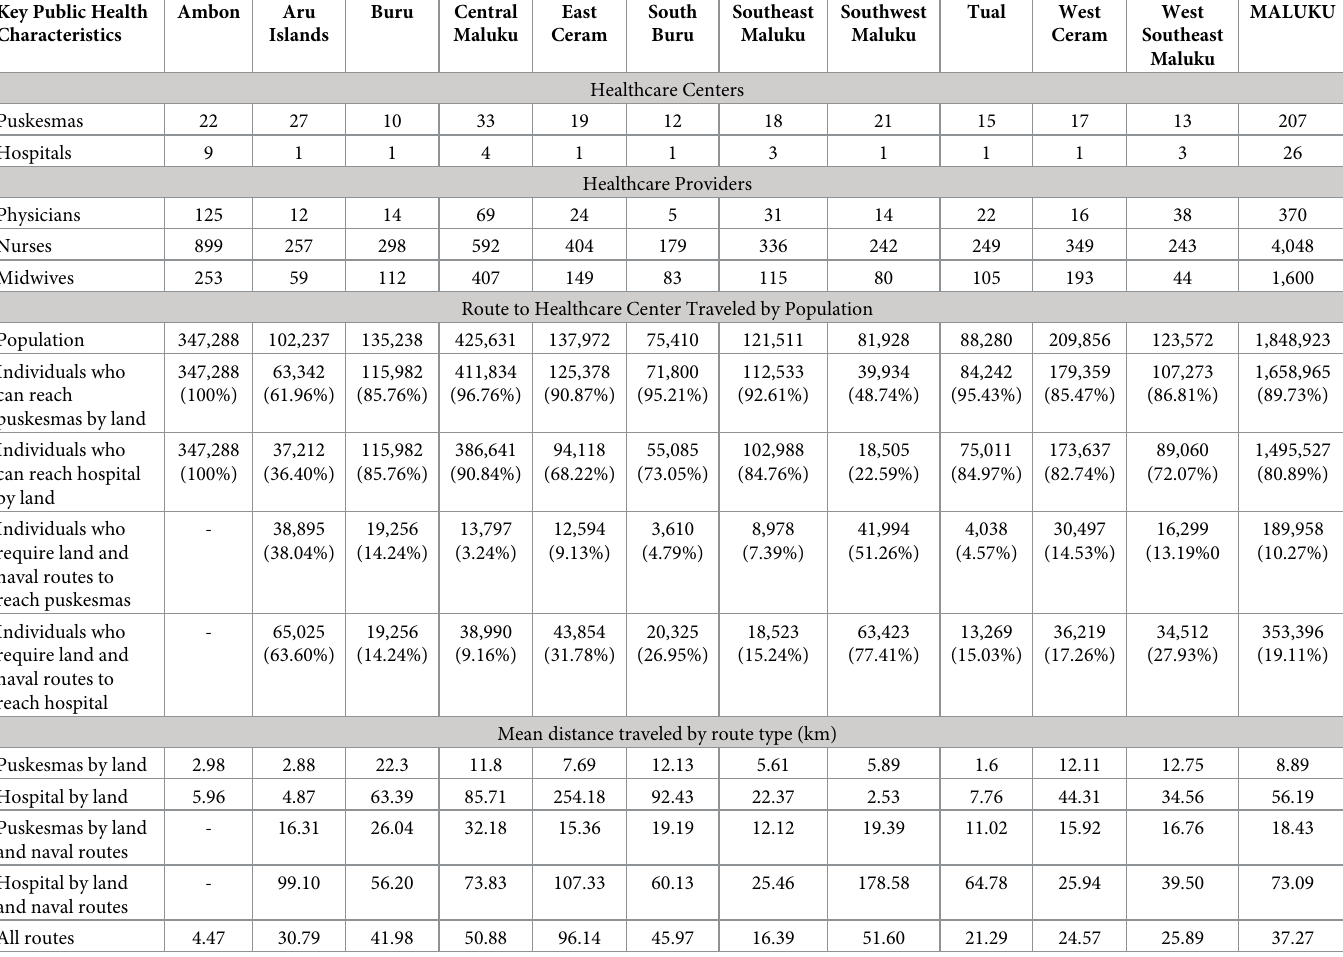
Table 1. Overview of key public health characteristics by district. These values provide the foundation for comparison of overall healthcare equity for individuals within each district. Key Public Health